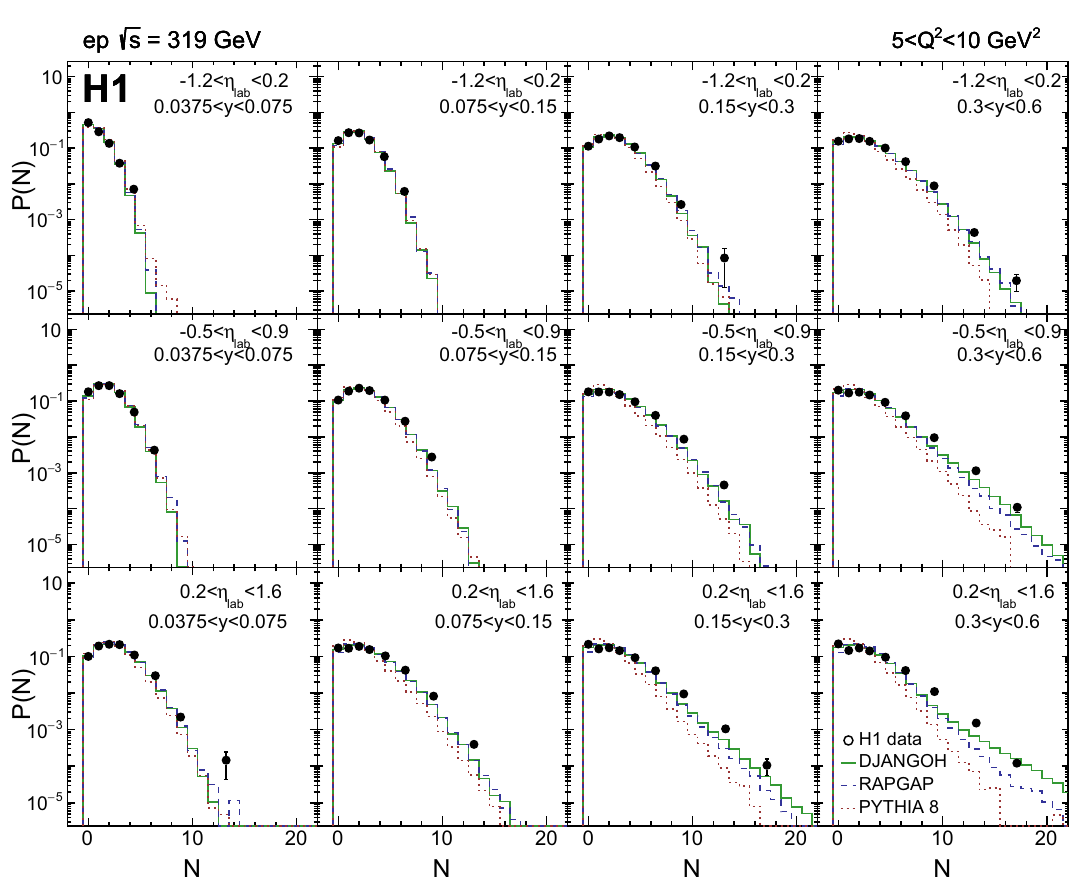
Fig. 3 Charged particle multiplicity distributions P ( N ) as a function indicated by the text in the figure. Predictions from DJANGOH, RAP- √ s = 319GeV ep collisions in the of the number of particles N at GAP and PYTHIA 8 are also shown. The total uncertainty is denoted range 5 < Q 2 < 10 GeV 2 . Further phase space restrictions are given by the error in Table 1. Different panels correspond to different η and y bins, as lab